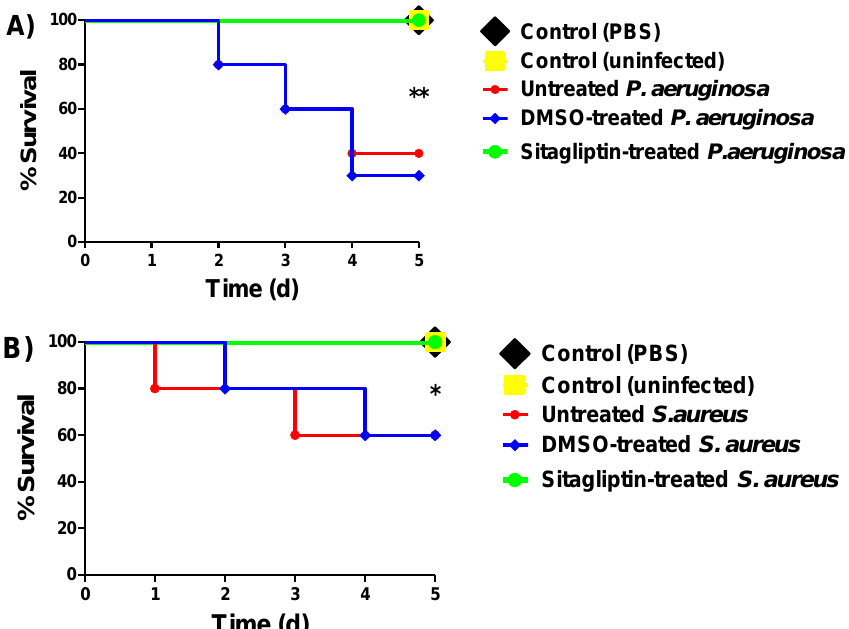
Figure 3. In vivo protection against P. aeruginosa and S. aureus . Ten mice groups were established to evaluate the antivirulence activity of sitagliptin at sub-MIC against P. aeruginosa and S. aureus . Five mice groups were intraperitoneally injected with untreated P. aeruginosa , DMSO-treated P. aeruginosa, sitagliptin-treated P. aeruginosa , or sterile PBS, and the last group was uninjected. The same grouping was used for evaluation against S. aureus : five mice groups were injected with untreated S. aureus , DMSO-treated S. aureus, sitagliptin-treated S. aureus , or sterile PBS or remained uninjected. The deaths among mice groups were recorded and plotted by Kaplan–Meier method, and log-rank test was employed to test the significance. ( A ) Protection against P. aeruginosa : sitagliptin protected all mice, in comparison to 3 deaths in the positive control groups that were injected with untreated P. aeruginosa , conferring 60% protection. ( B ) Protection against S. aureus : sitagliptin protected all mice, while two deaths were recorded in positive control groups that were injected with untreated S. aureus , conferring 40% protection. Sitagliptin showed significant reduction in the capacity of P. aeruginosa and S. aureus to kill mice; log-rank test p = 0.0028 and 0.0244, respectively. *: p ≤ 0.05, **: p ≤ 0.01 .